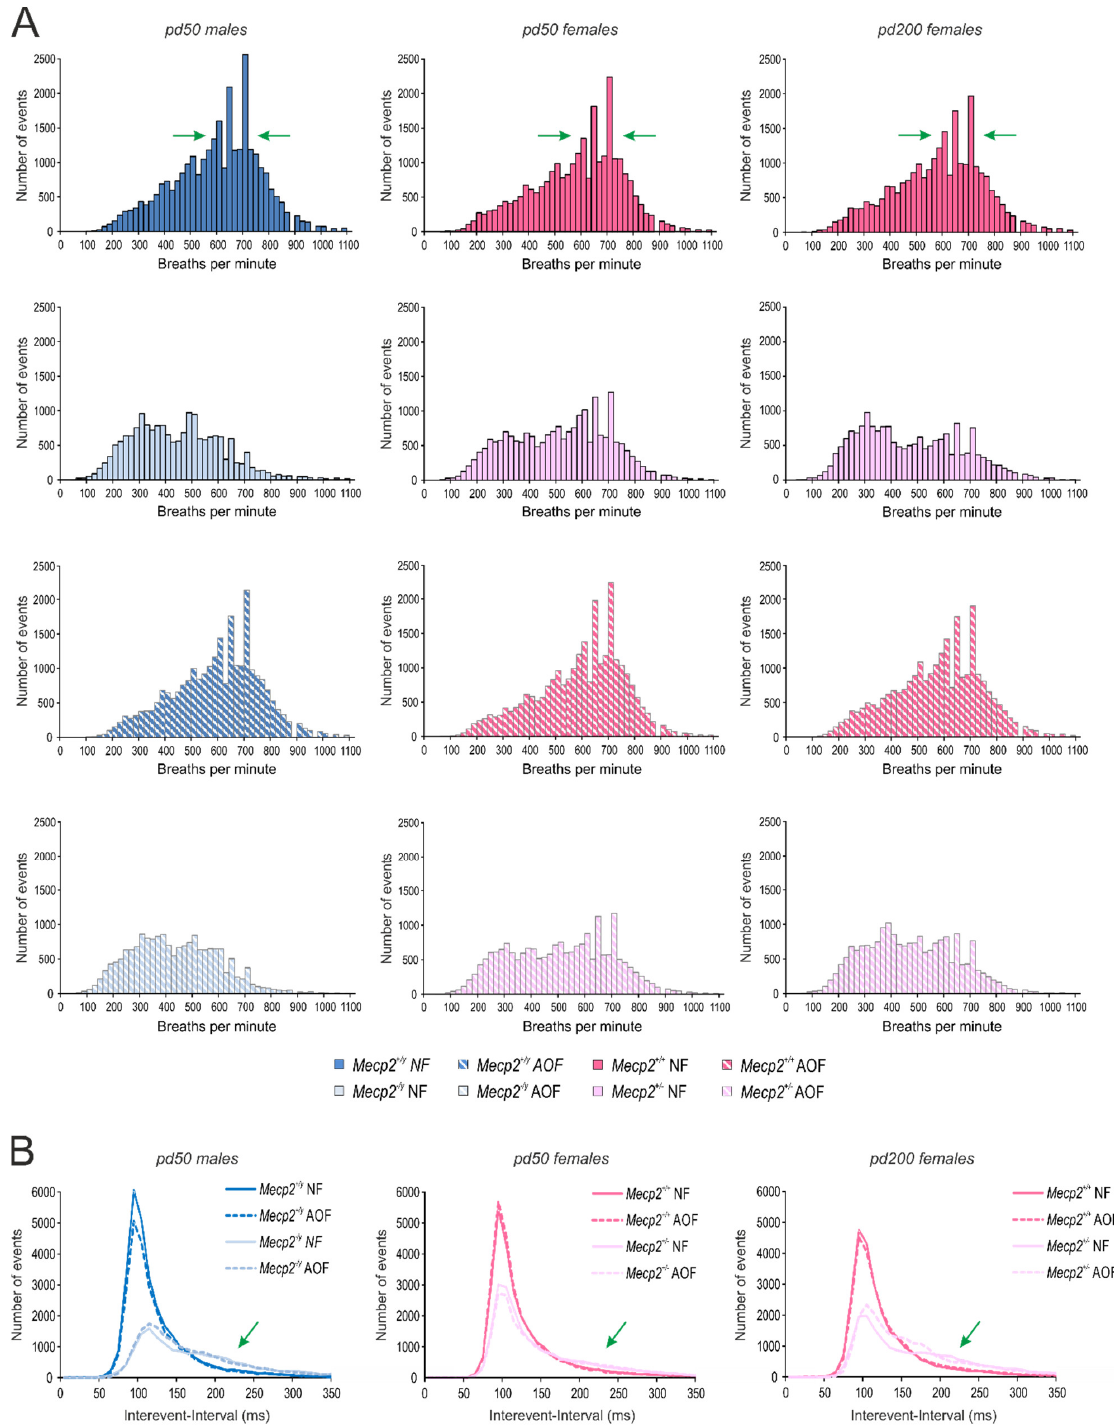
Figure 5. Spectral analyses revealed the full complexity of breathing. ( A ) Breathing patterns were composed of frequencies ranging between 100 and 1100 breaths per minute. In Mecp2 −/ y and Mecp2 +/− mice, this distribution was left-shifted as higher frequencies were less prominent. Green arrows flank those frequencies (550–700 BPM) associated with grooming and exploratory activities. AO treatment did not affect the frequency composition of the respiratory patterns. ( B ) The interevent interval, i.e., the timespan between two breaths, also showed a defined spectral range that was markedly broadened (see arrow mark) in Mecp2 − / y and Mecp2 +/ − mice as compared with WTs. Data represent 24–25 mice per